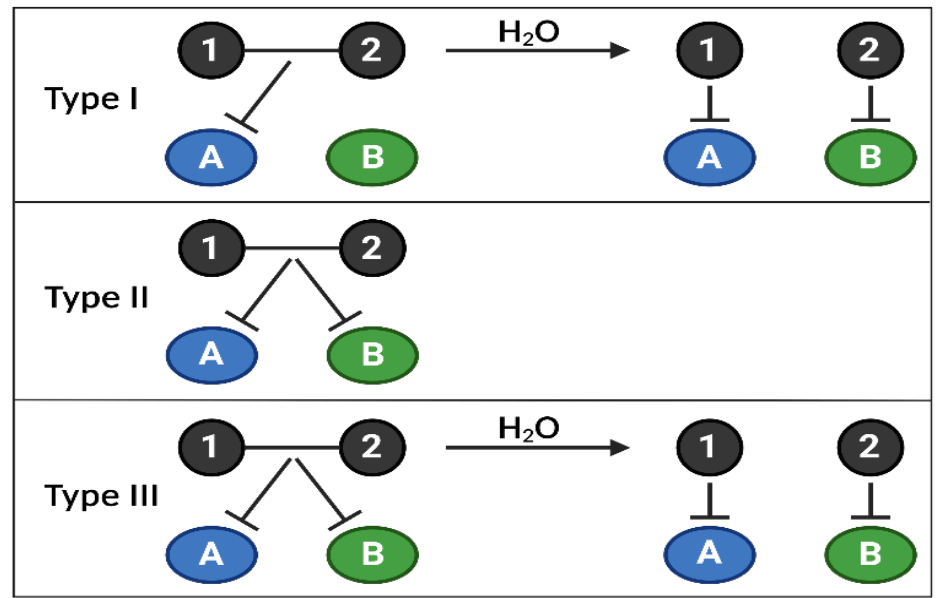
Figure 4. Combi/hybrid molecules, annihilating several targets at once. The use of targeted therapies in clinics has highlighted the appearance of frequent treatment resistance due to the activation of compensatory feedbacks, requiring inhibiting several signaling nodes at once. Combi- or hybrid molecules have been developed to overcome these limitations by targeting several biological targets (kinases, DNA, etc.) with one entity, allowing better control of the pharmacokinetics and pharmacodynamics of drug combinations. Currently, there are 3 types of combi/hybrid molecules, depending on their mechanism of action. Type I can block target A as an intact molecule but is required to be hydrolyzed to block A and B; Type II can block targets A and B without being hydrolyzed; Type III can block targets A and B as an intact molecule or after being hydrolyzed. Combi/hybrid molecules are one of the proposed novel therapeutic solutions to target specific PI3K isoforms among the 3 classes, depending on their relative importance in a type of cancer, using only one molecule.